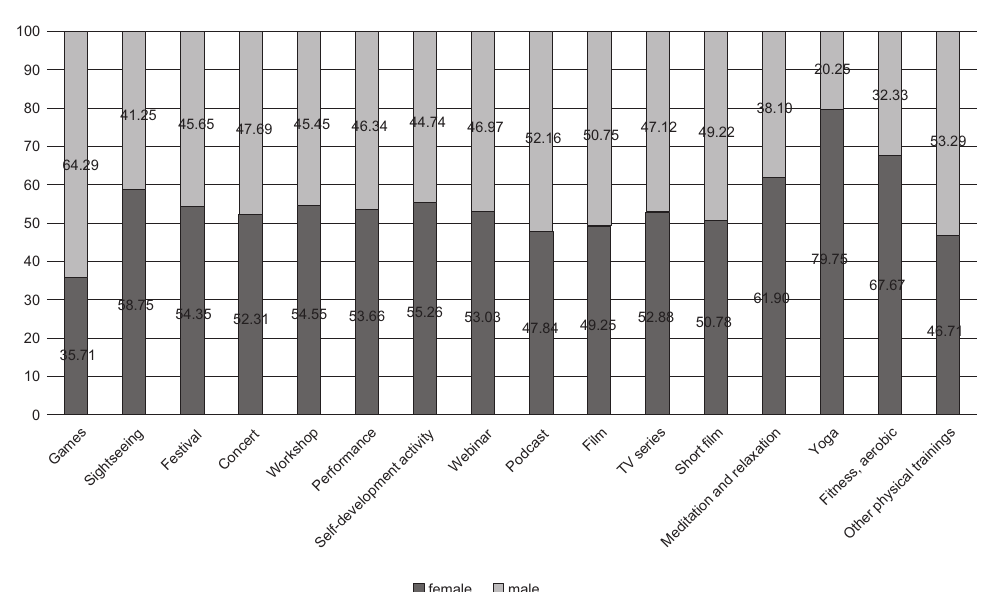
Fig. 2. Computer-based entertainment activities undertaken by the respondents with respect to sex. Source: own elaboration based on online questionnaires. Table 2. Computer-based entertainment activities undertaken by respondents and their motivations (%) .